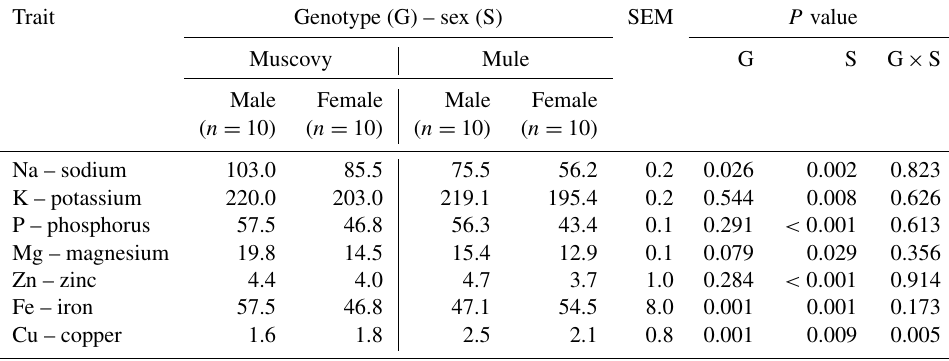
Table 4. Content of some minerals in milligrams per 100g of liver from ducks of different genotypes. Trait